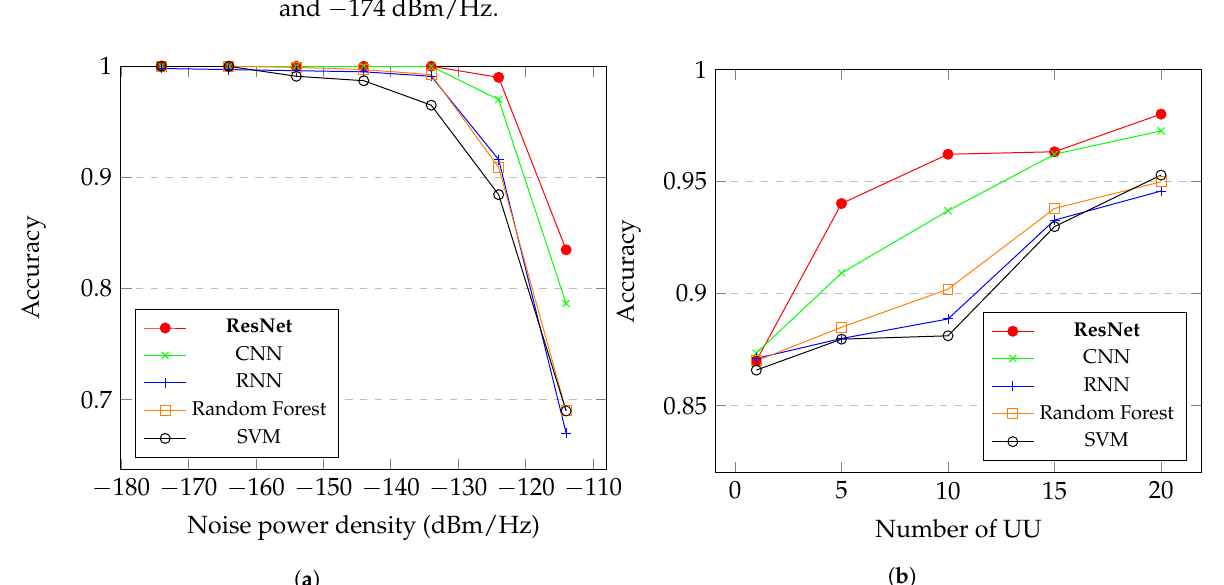
Figure 11. Graphics of the proposed ResNet in comparison with other machine learning and deep learning approaches with variation of ( a ) N 0 and ( b ) N UU .